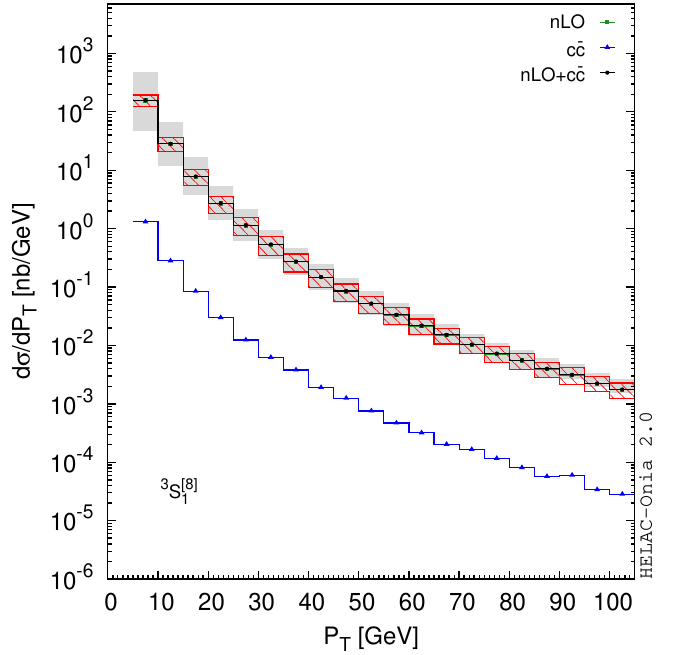
Figure 16 . Comparisons of spin-summed differential cross sections d(cid:27) between our nLO calculations and the LO charmonium plus charm quark pair calculations.